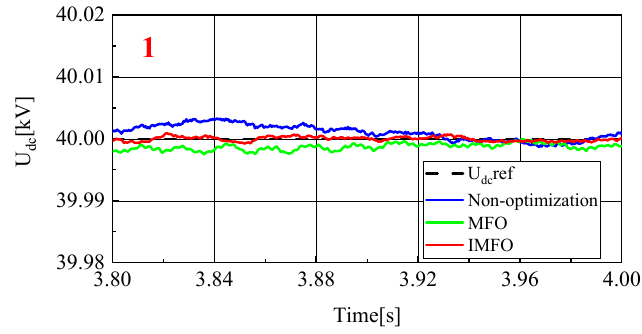
Figure 9. Local amplified waveform of DC side voltage.